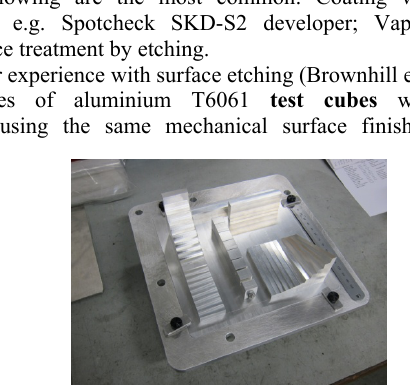
Figure 4. Technical drawing (CAD) of the geometric base plate